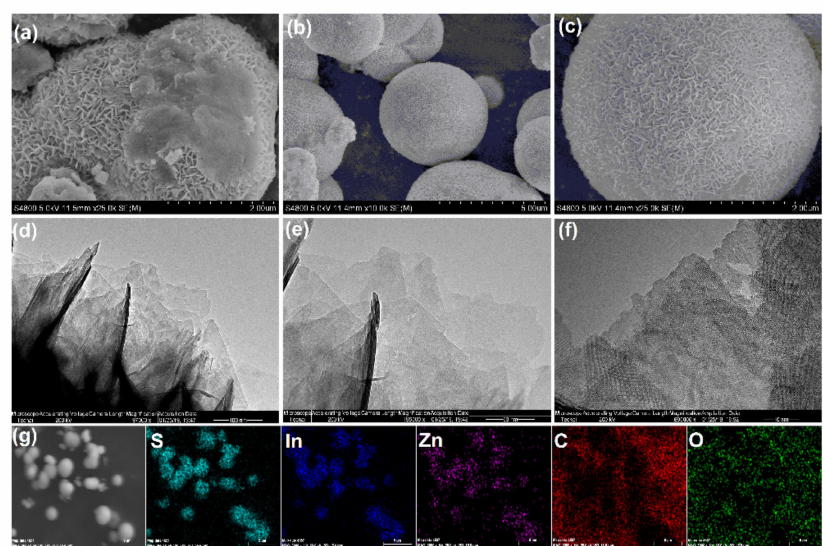
Figure 1. SEM images of ZnIn 2 S 4 ( a ) and rGO / ZIS-1 ( b,c ); TEM images of rGO / ZIS-1 with di ff erent magnification ( d–f ); TEM image of rGO / ZIS-1 and corresponding energy-dispersive X-ray spectroscopy (EDS) elemental mapping for S, In, Zn, C, and O ( g